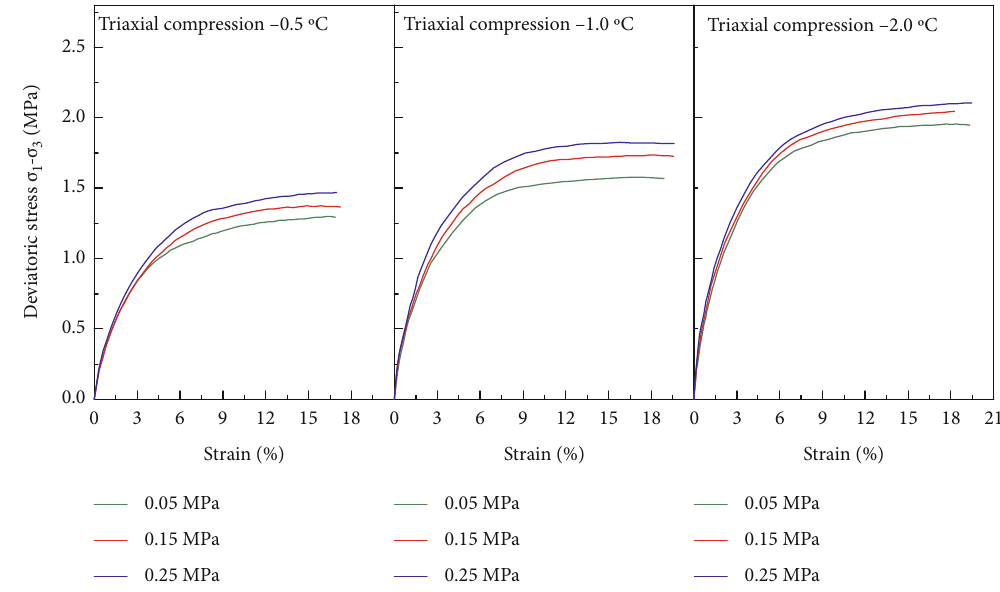
Figure 5: Triaxial compression test stress-strain curve of frozen silty clay. Table 6: Basic mechanical parameters of the model.